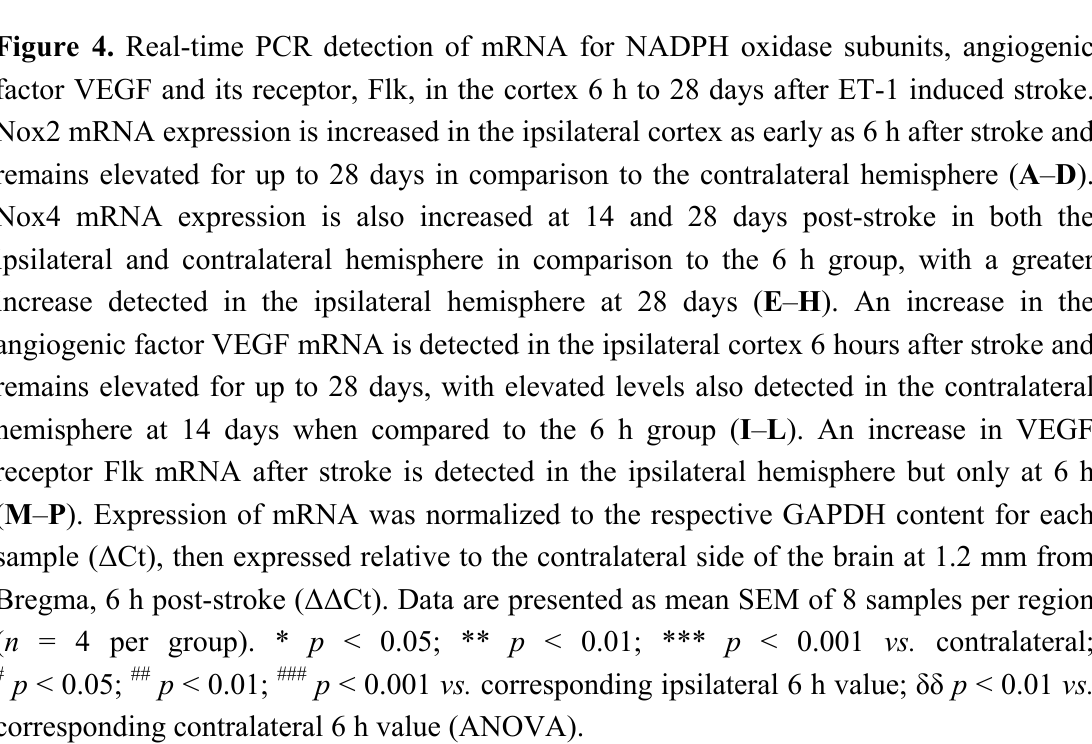
Figure 4. Real-time PCR detection of mRNA for NADPH oxidase subunits, angiogenic factor VEGF and its receptor, Flk, in the cortex 6 h to 28 days after ET-1 induced stroke. Nox2 mRNA expression is increased in the ipsilateral cortex as early as 6 h after stroke and remains elevated for up to 28 days in comparison to the contralateral hemisphere ( A – D